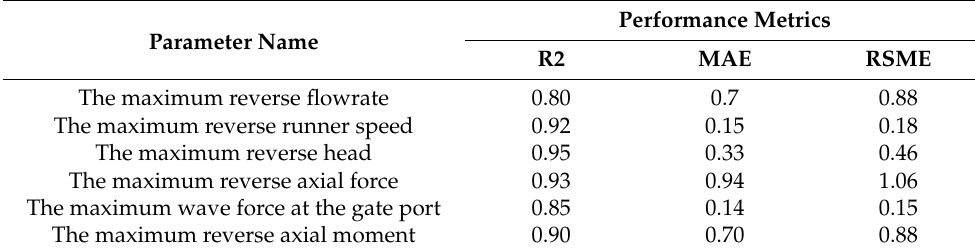
Table 2. Performance matrix of typical parameters in the five